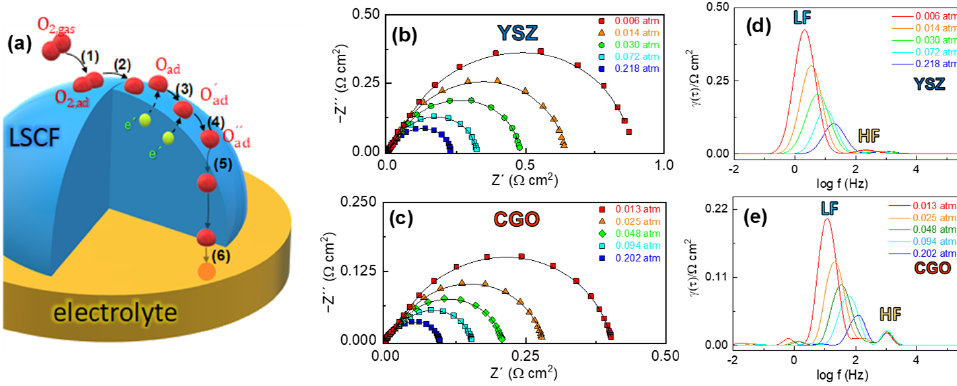
Figure 5. Overall polarization resistance of LSCF nanostructured electrodes deposited onto different electrolytes as a function of temperature. The inset figure compares the polarization resistance at 700 °C.